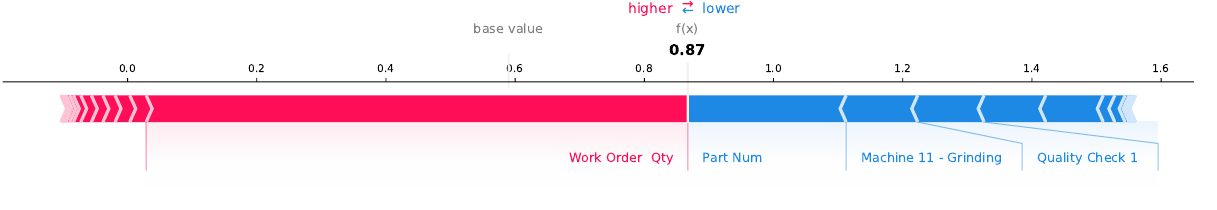
Figure 17. SHAP values of Ball